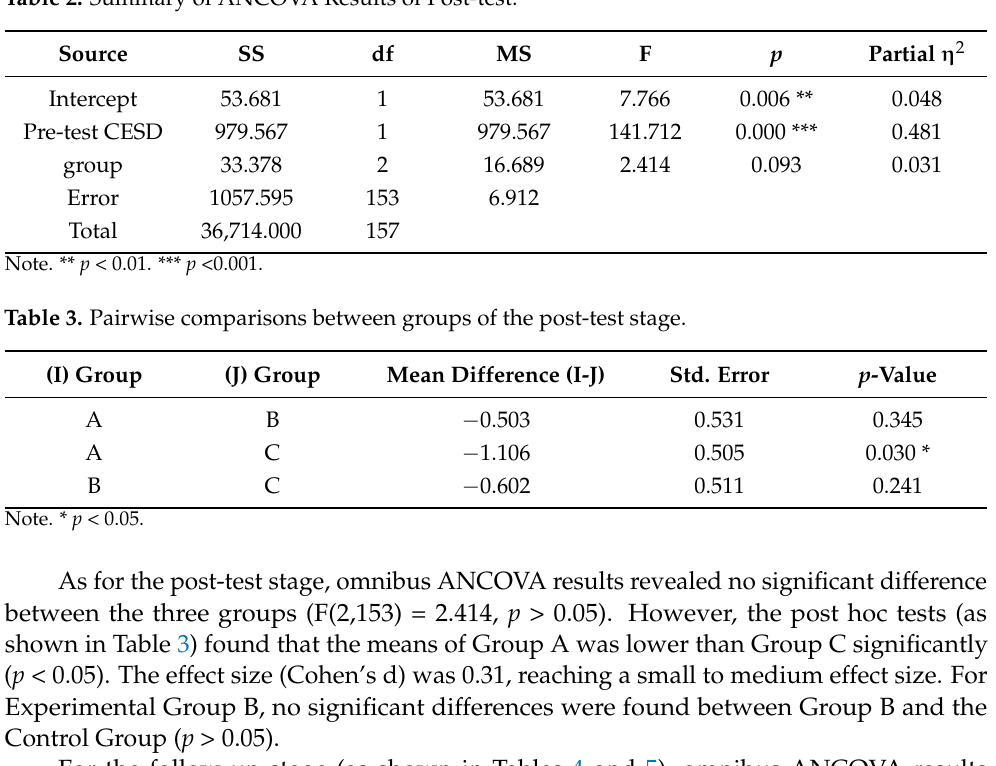
Table 4. Summary of ANCOVA Results of Follow-up—test. Source SS df MS F p